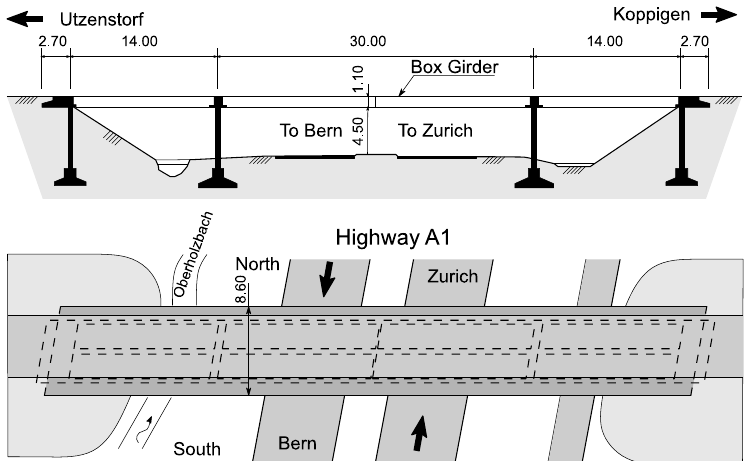
Figure 3. Bridge Z-24 schematic drawing (units are in meters; adapted from [142]).